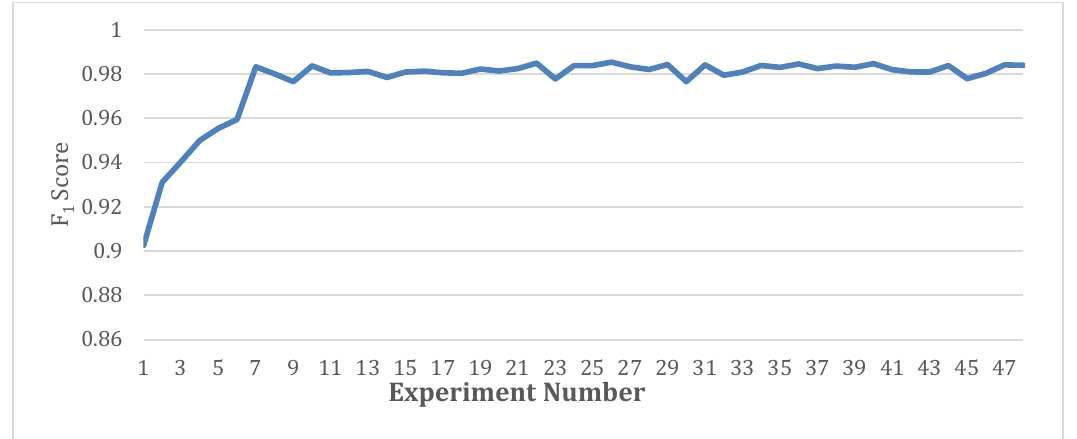
Figure 9. Performance curves showing the results of 48 experiments together (Tables 7–11) at different scales, sizes, and streams.